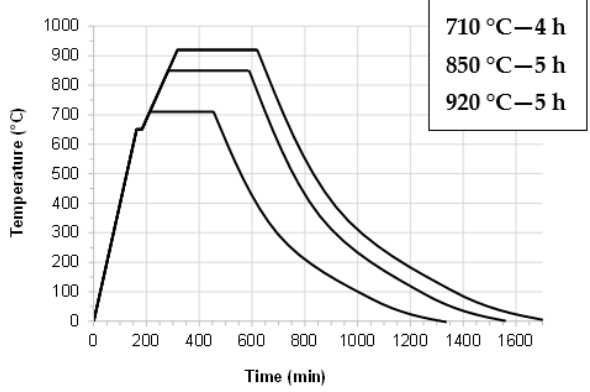
Figure 7. Recorded temperature profiles of thermal treatments.